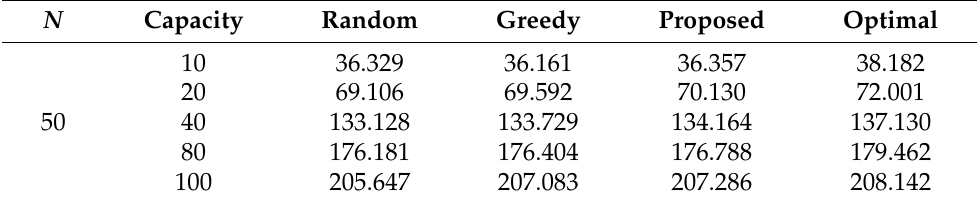
Table 11. Average profit of selected items per capacity in